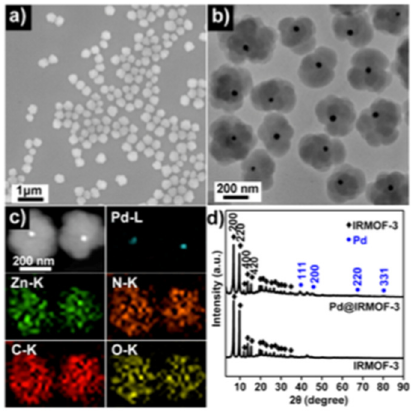
Figure 3. SEM image of the core–shell PdNPs@IRMOF-3 material ( a ), TEM image of the material ( b ), HAADF-STEM image with the corresponding EDX elemental mapping ( c ), PXRD of HAADF-STEM image with the corresponding EDX elemental mapping ( c ), PXRD of PdNPs@IRMOF- PdNPs@IRMOF-3 and pure IRMOF-3 ( d ) [27]. Reproduced from [27] with permission from the 3 and pure IRMOF-3 ( d ) [27]. Reproduced from [27] with permission from the American Chemi- American Chemical Society. cal